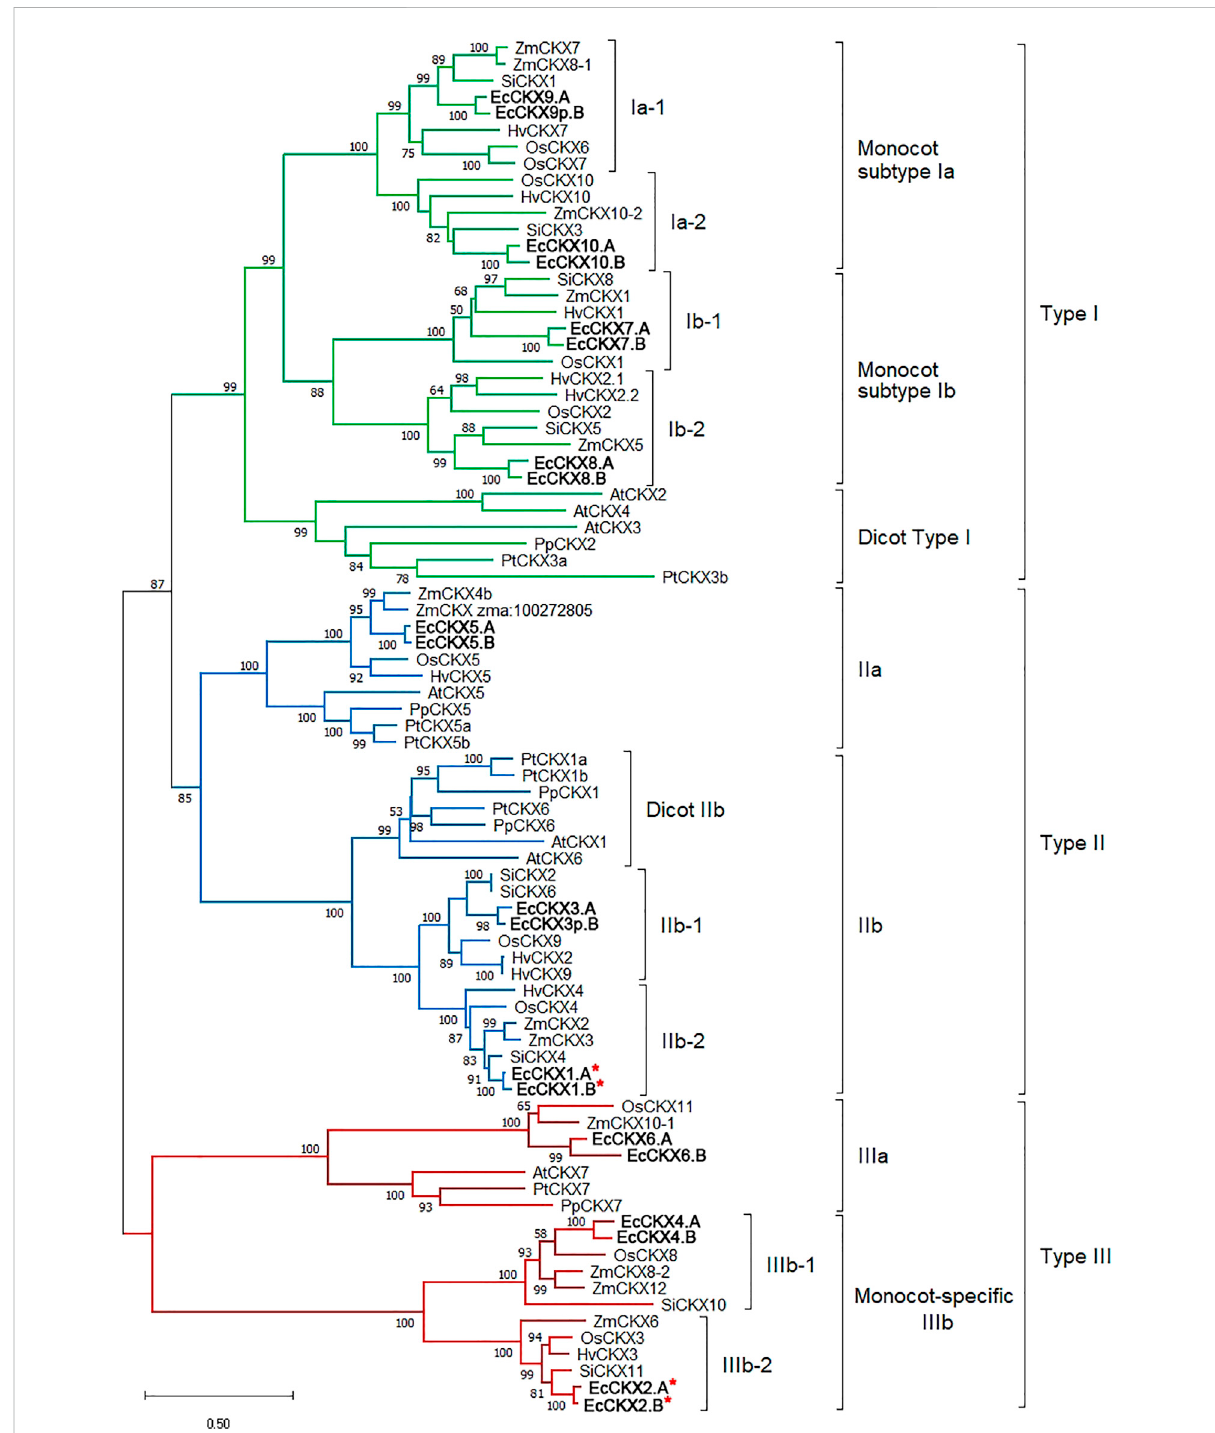
FIGURE 4 Unrooted ML phylogenetic tree for dicot ( A. thaliana , P. persica , and P. trichocarpa ) and monocot ( O. sativa , Z. mays , H. vulgare , and S. italica ) CKX proteins, as well as translated peptides of identi fi ed genes in E. coracana genome. The tree was constructed with bootstrap support of 1,000 iterations (50% and higher values are displayed). A red asterix denotes genes identical to previously sequenced and characterized EcCKX1 and EcCKX2